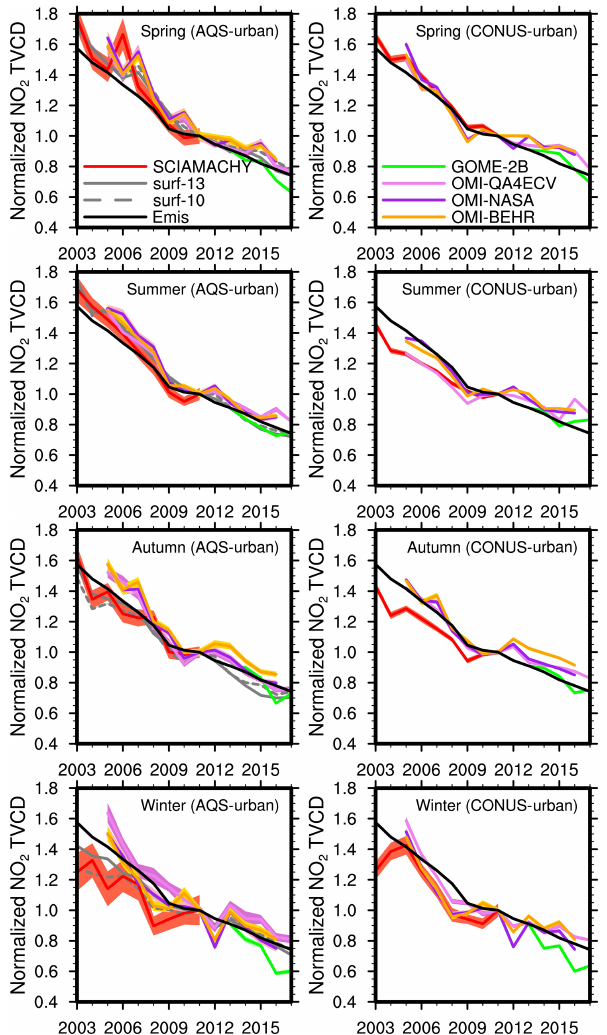
Figure 6. Relative variations in AQS NO 2 surface measurements at 13:00–14:00LT and 10:00–11:00LT, updated EPA anthropogenic NO x emissions, and satellite NO 2 TVCD data over the AQS urban sites (left column) and the CONUS urban regions (right column) for four seasons. AQS NO 2 surface measurements are not included in the right column. All datasets are scaled by their corresponding val- ues in 2011 except for GOME-2B. For GOME-2B, we firstly nor- malized the values in each season to the corresponding 2013 values and plotted the relative changes from the 2013 EPA point of each season to make the GOME-2B relative variations comparable to the other datasets. Shading in a lighter color is added to show the stan- dard deviation of the results; when uncertainty is small due in part to a large number of data points, shading may not show up.